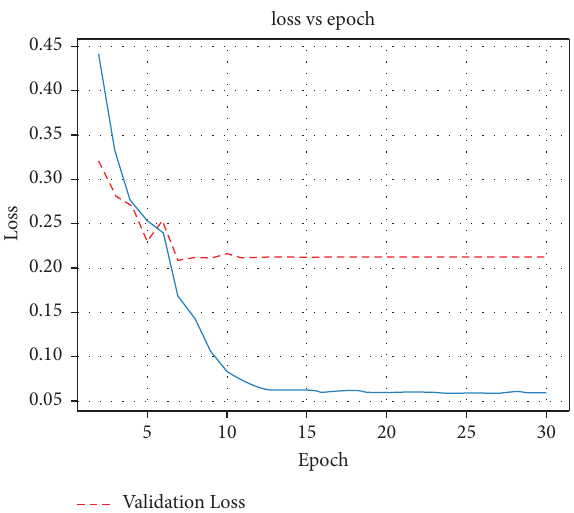
Figure 17: Observed loss for case 6.